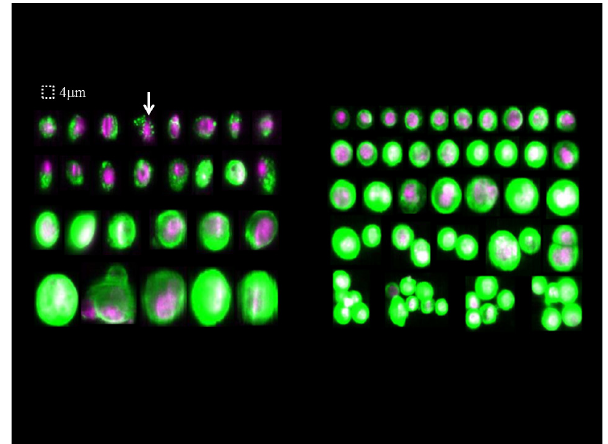
Figure 2. Tumor cells detected in the ascitic fluid of the patient with the ultimate diagnosis of esophageal cancer (Papanicolaou stain, ×1000).